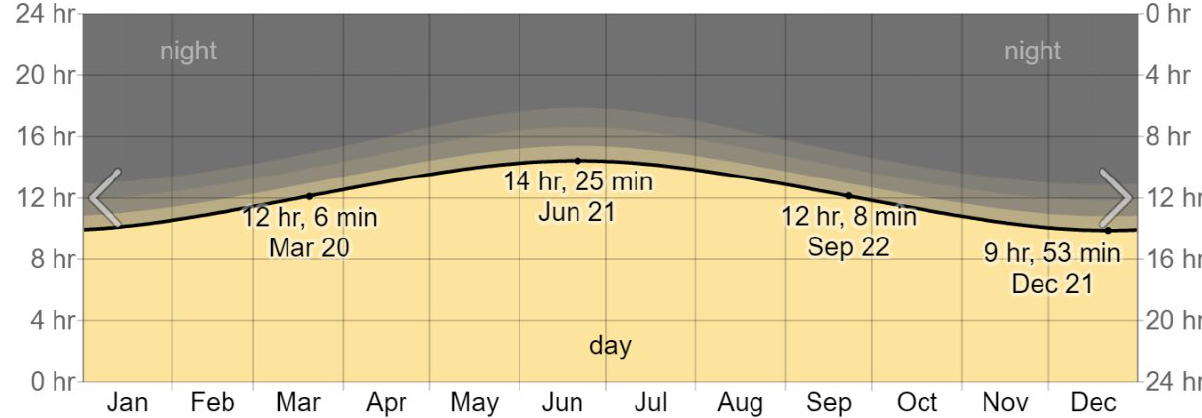
Figure 5. Sun hours in Rabat, Morocco, during the year 2021 [37].